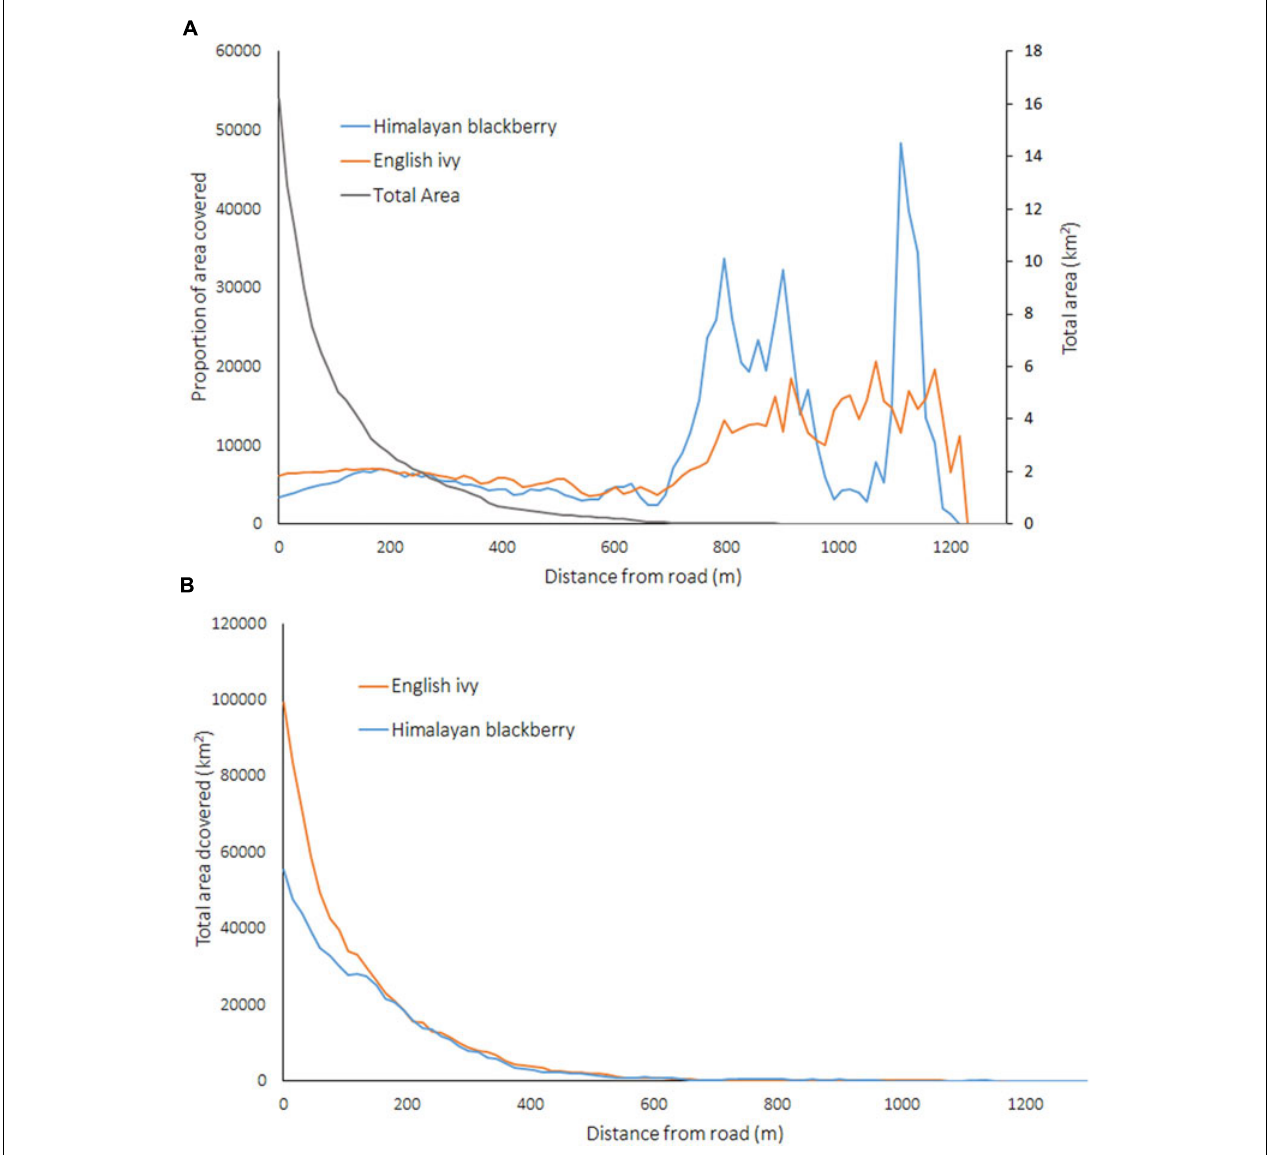
FIGURE 9 | (A) Proportion covered by Himalayan blackberry ( Rubus armeniacus ) and English ivy ( Hedera helix ) and the total area covered in the city related to the distance from roads, and (B) total area covered by Himalayan blackberry ( Rubus armeniacus ) and English ivy ( Hedera helix ) related to the distance from roads in Surrey, BC,